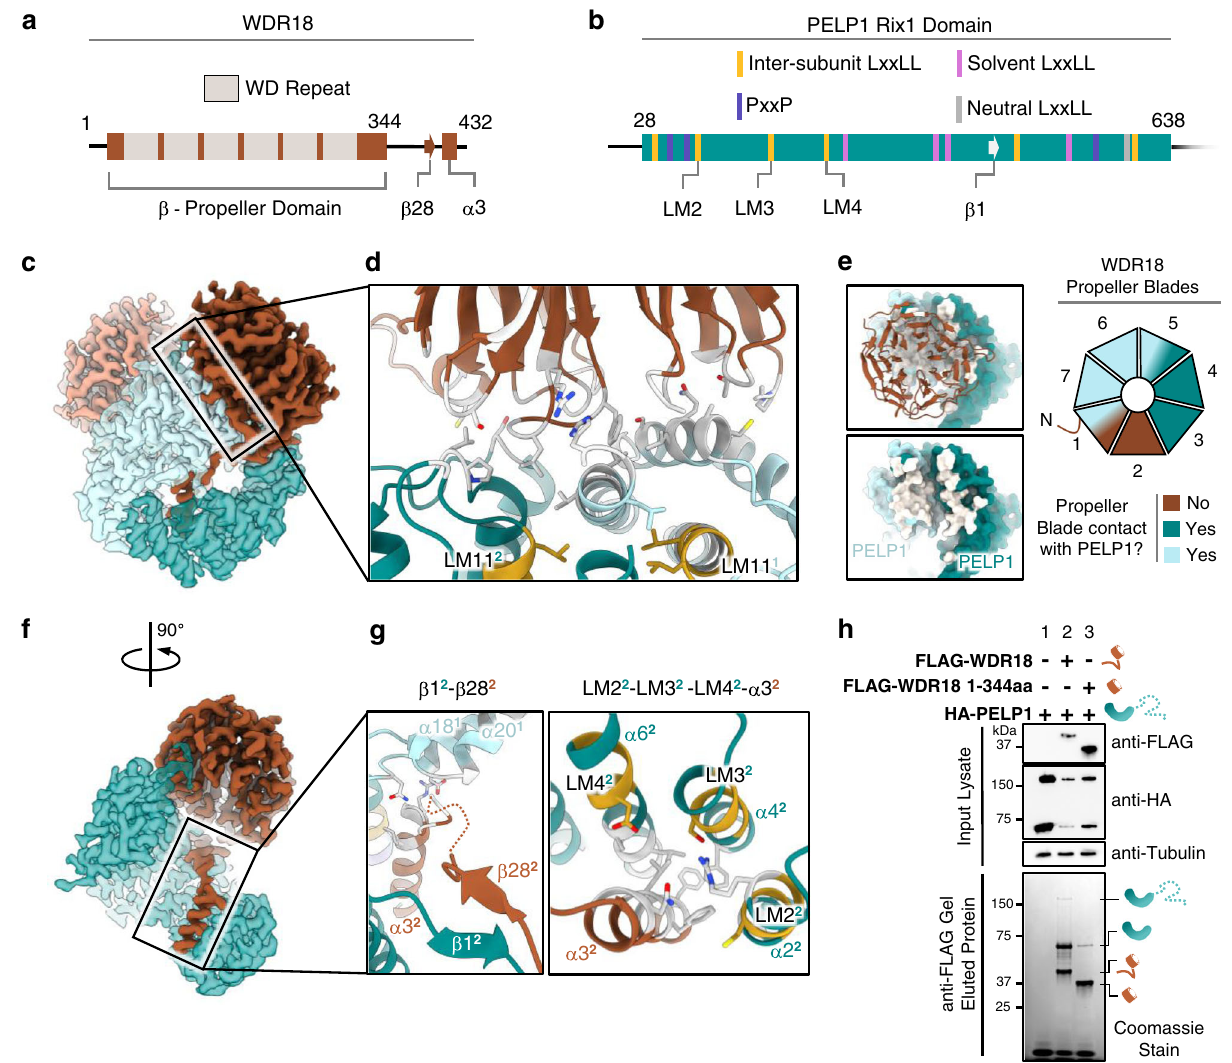
Fig. 4 | Structural basis of PELP1 Rix1 domain interaction with WDR18. a SchematicrepresentationofWDR18withWDrepeatregionsthatcontributeto β - propeller domain and features of the C-terminal tail noted below. b Schematic representation of PELP1 ’ s Rix1 domain with localization of LxxLL and PxxP motifs. Speci fi c motifsand features involved in PELP1-WDR18 interaction are noted